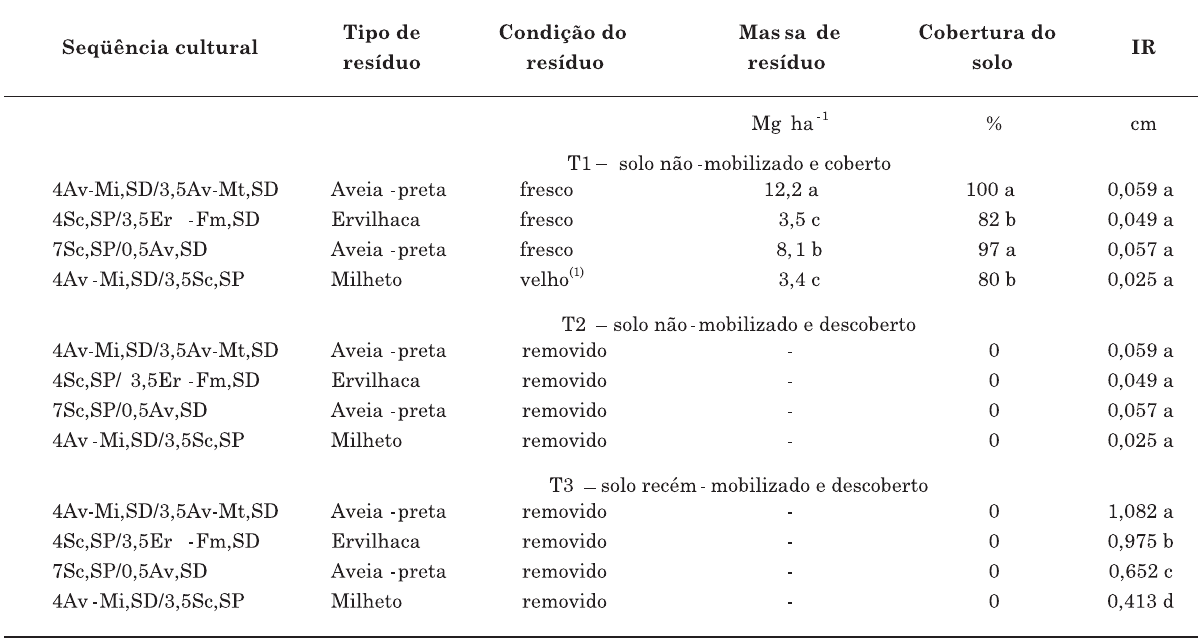
Na figura 3, são apresentados os resultados